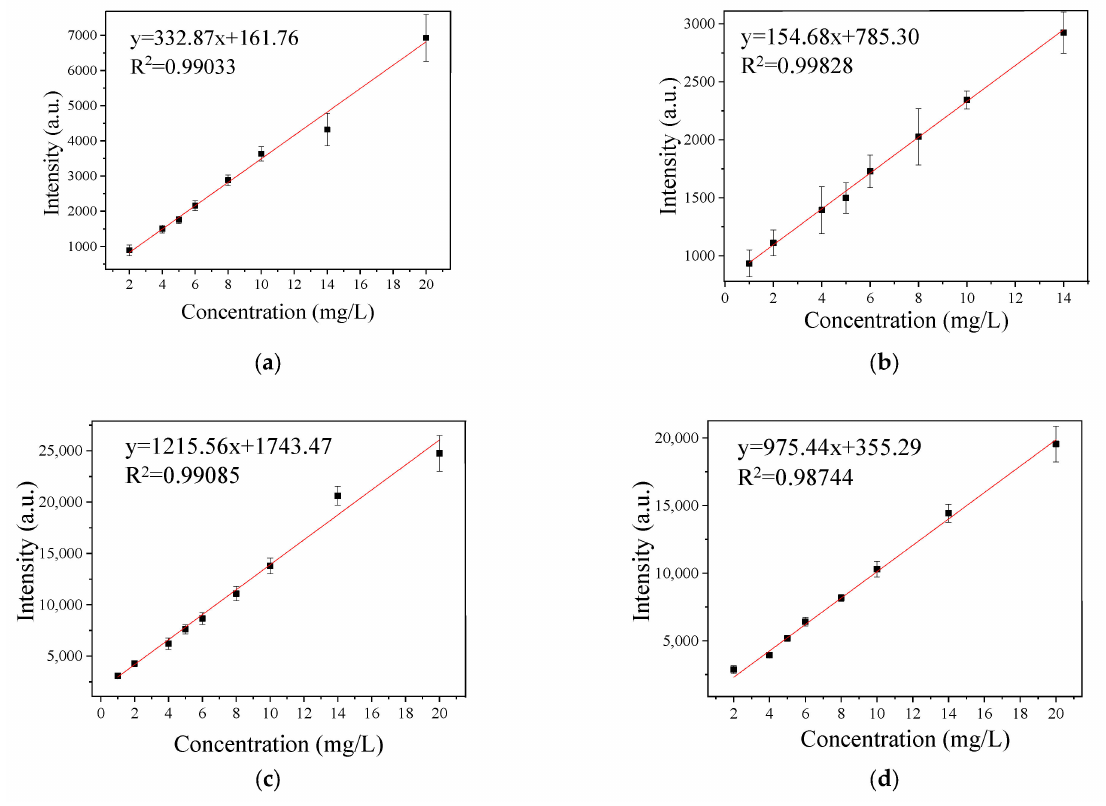
Figure 8. Calibration model: ( a ) Cr; ( b ) Cu; ( c ) Pb; ( d )